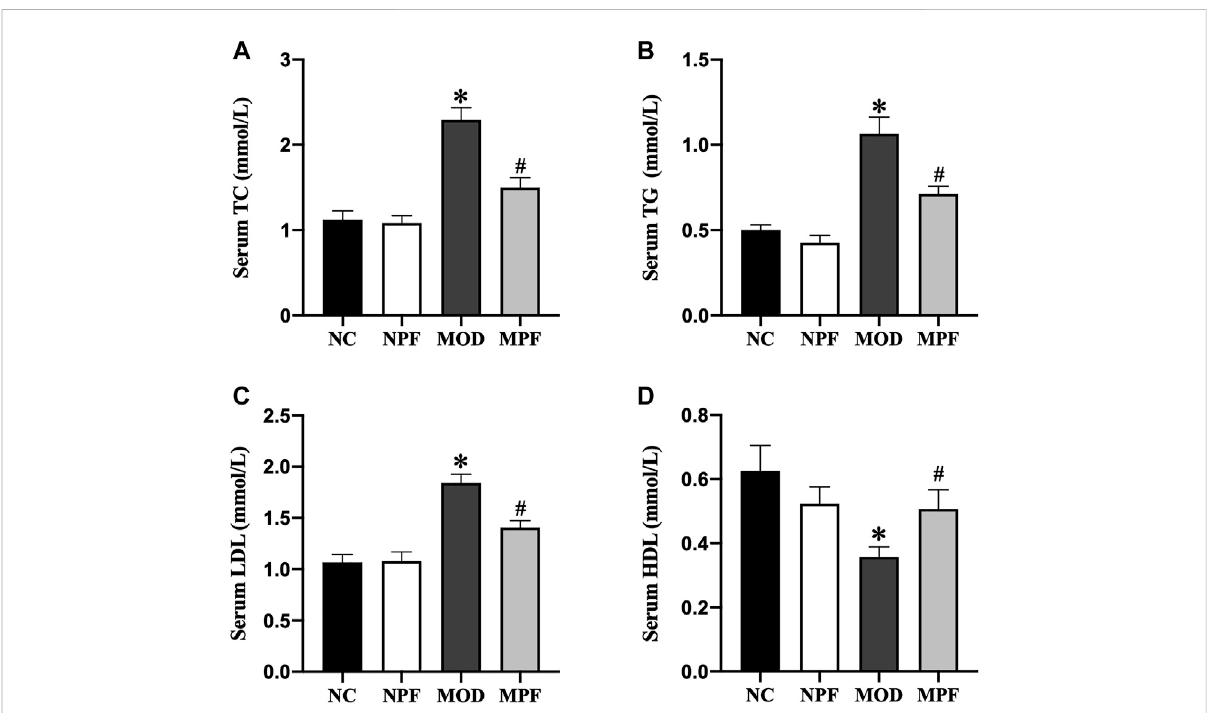
Effects of paeoni fl orin (PF) on lipids level in serum. Serum levels of (A) TC, (B) TG, (C) LDL, and (D) HDL. Serum samples were obtained from the normal control group (NC), PF-treated control group (NPF), model group (MOD), and PF-treated model group (MPF). Data are presented as